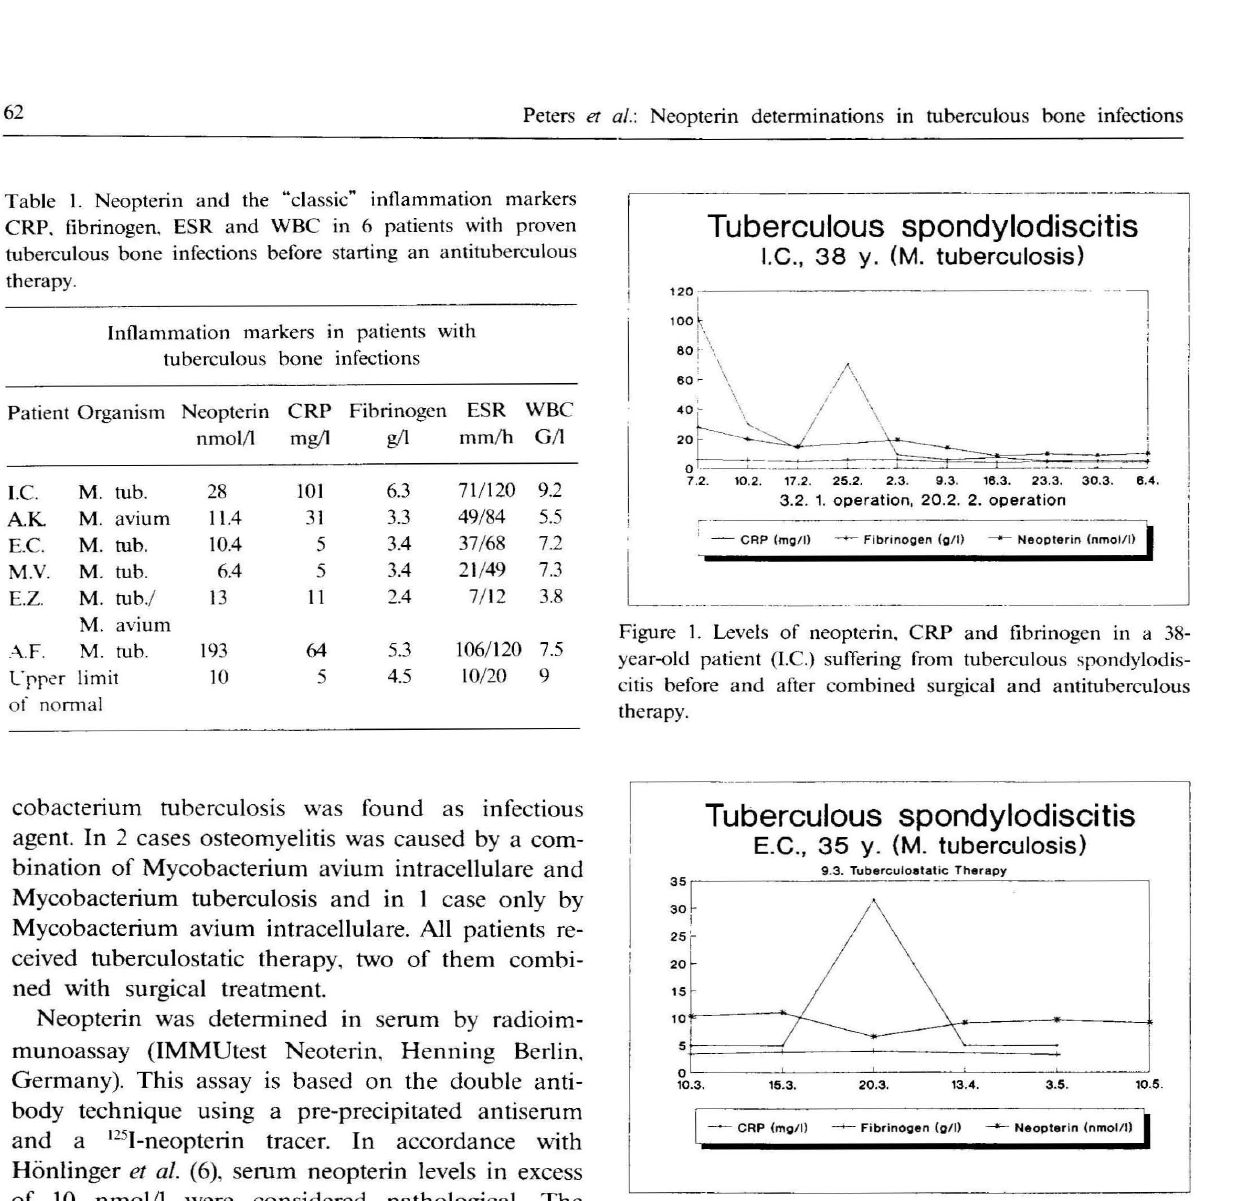
Figure 2. Levels of neopterin, CRP and fibrinogen in a 35- year-old patient (E.e.) suffering from tuberculous spondylodis citis before and after antituberculous therapy.